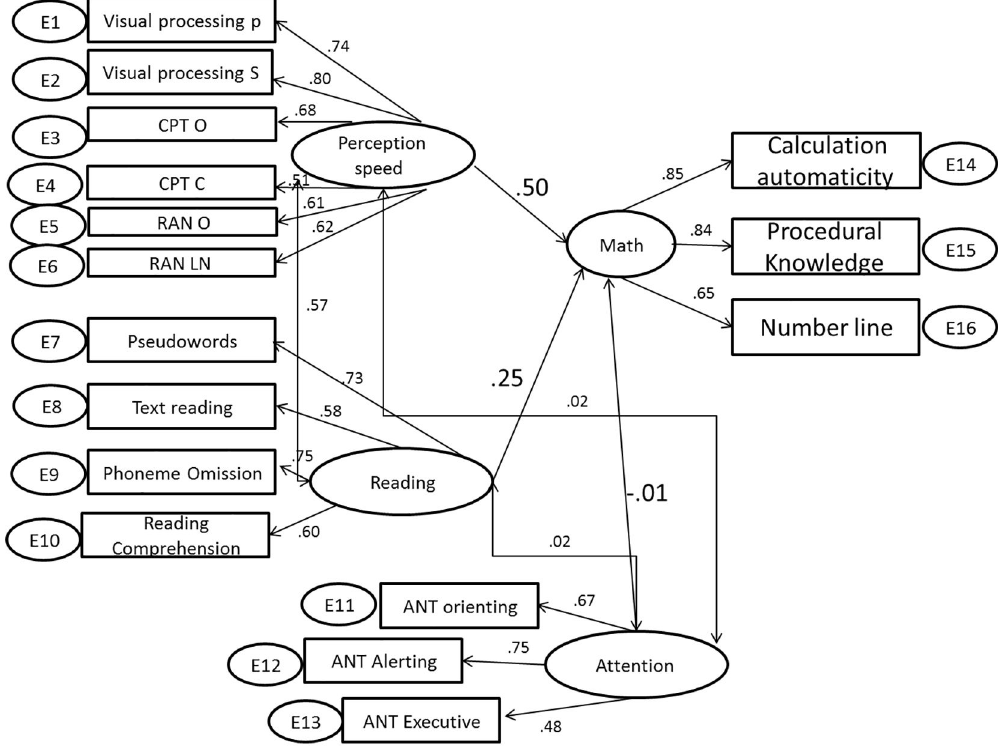
Figure 2. Default model based on the factor analysis including 3 latent variables: Perception speed, reading and attention (ANT) predict mathematics